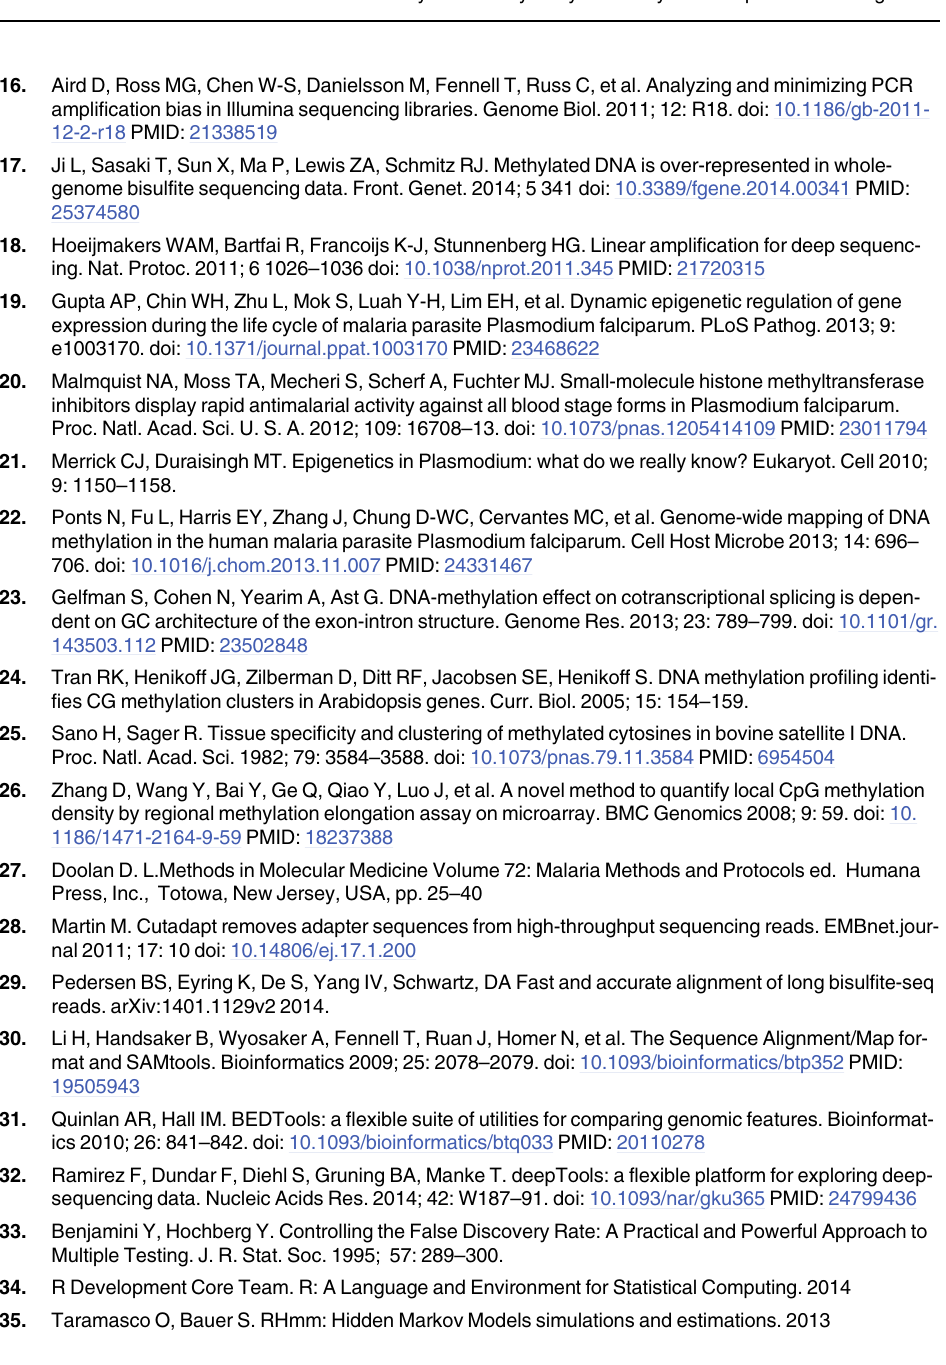
PLOS ONE | DOI:10.1371/journal.pone.0152322 March 31,